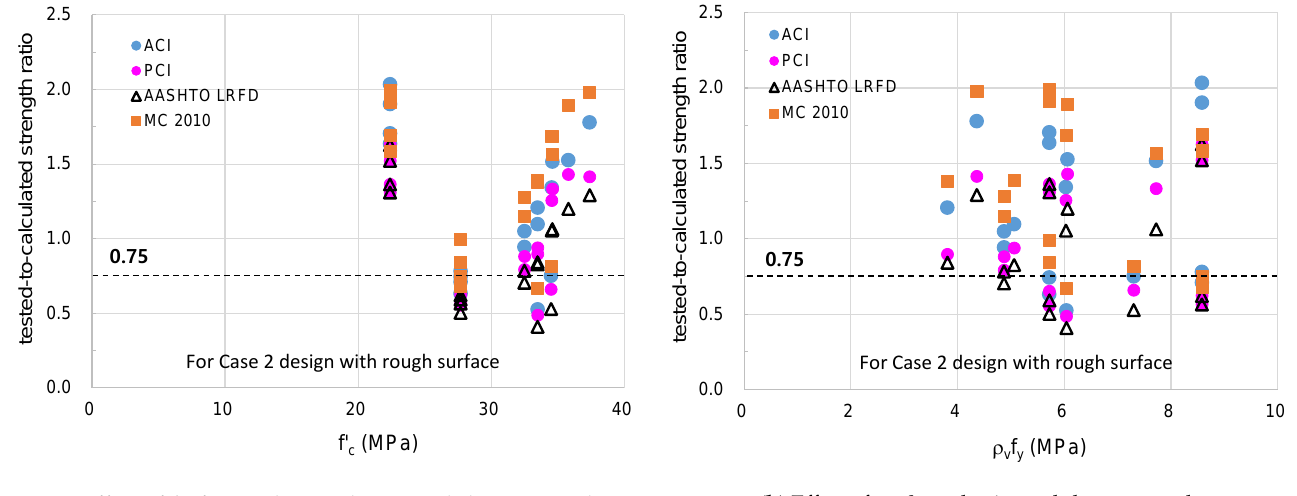
Figure 9 . Tested-to-calculated shear strength ratios for beam tests with Case 1 category (roughened surface).